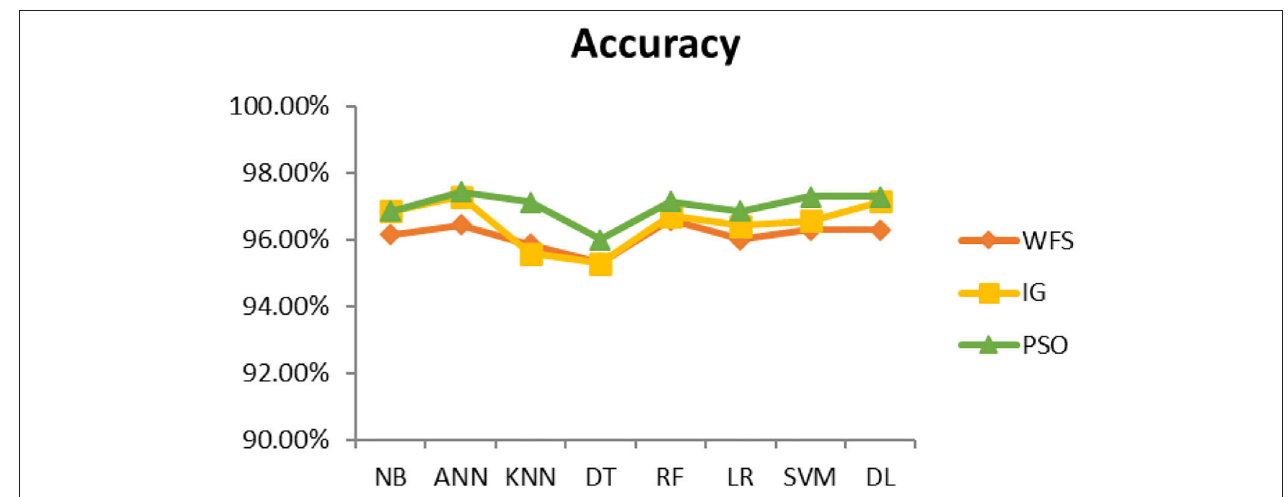
FIGURE 4 | Cancer diagnosis accuracy (dataset